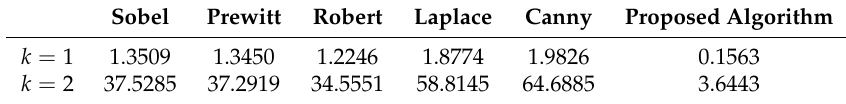
Table 2. Comparison of SD 1 and SD 2 between the proposed algorithm and other conventional ones. Sobel Prewitt Robert Laplace Canny Proposed